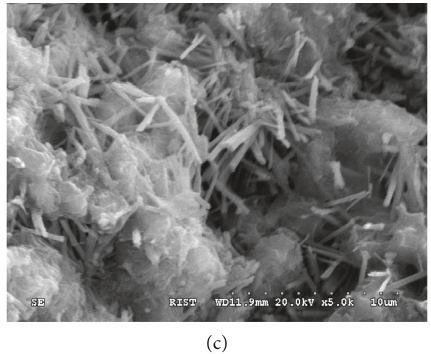
Figure 7: SEM images (x5000). (a) O100, (b) B80D20, and (c) B75D10G15.